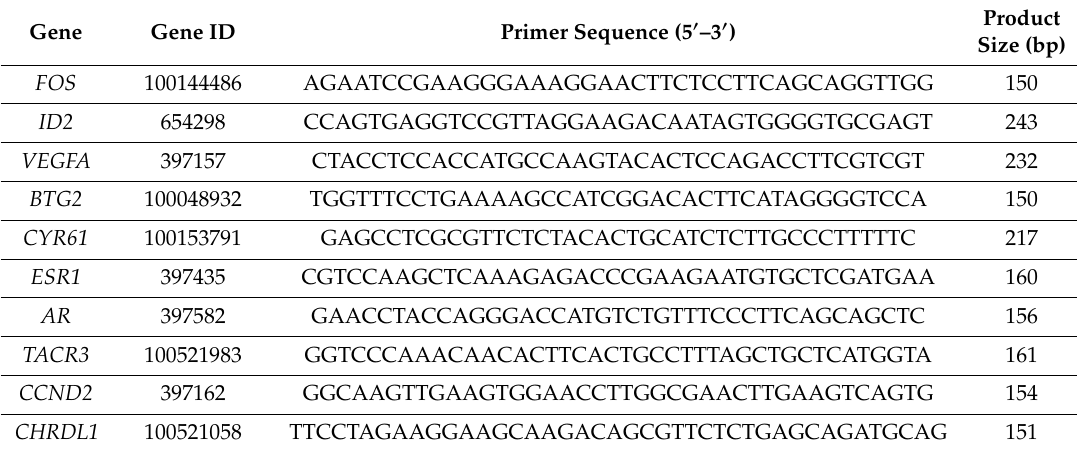
Table 2. Sequences of primers used for RT-qPCR validation of the microarray